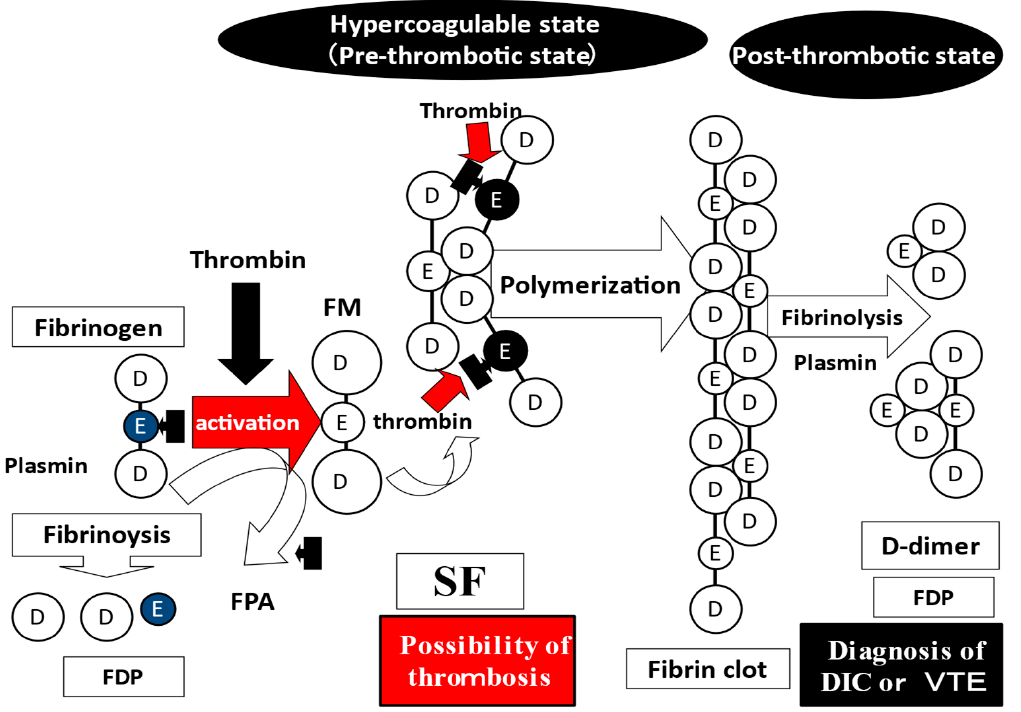
Figure 4. Soluble fi brin. SF, soluble fi brin; FDP, fi brinogen and fi brin degradation product; DIC, disseminated intravascular coagulation; VTE, venous thromboembolism; FPA, fi brinopepetide A.